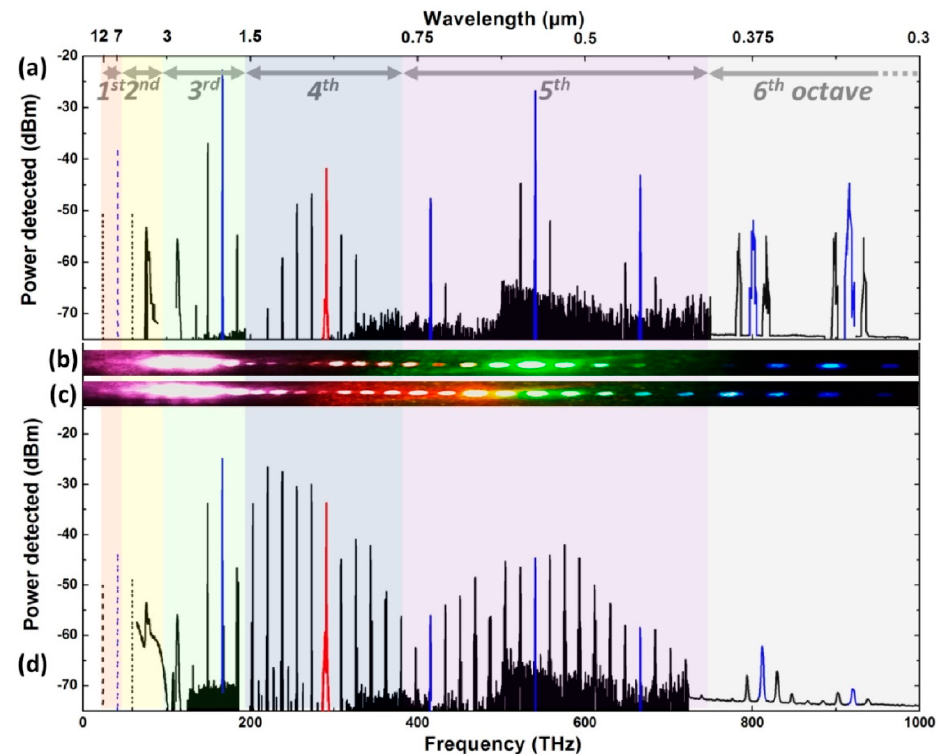
Figure 26. ( a , b ) Optical spectrum ( a ) and its associated diffracted output beam picture ( b ) generated with pump linear polarization. ( c , d ) same as ( a , b ) for pump circular polarization of a large optical Raman comb in H 2 IC HCPCF (reprinted with permission from Reference [10], OSA, 2015).